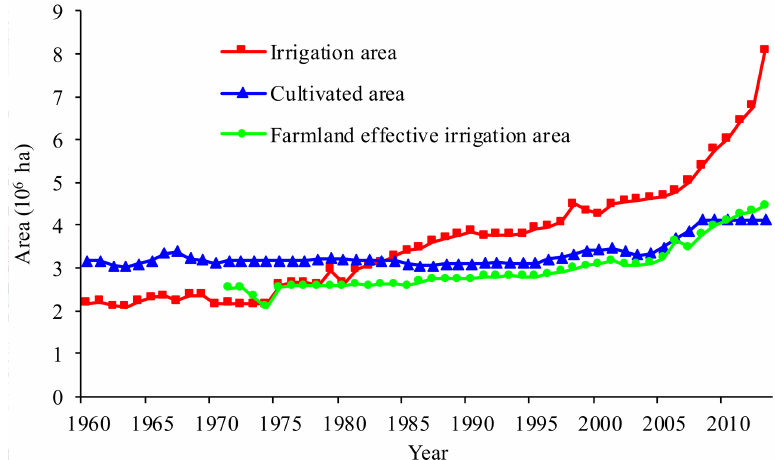
Figure 2. Irrigation area increase in Xinjiang,